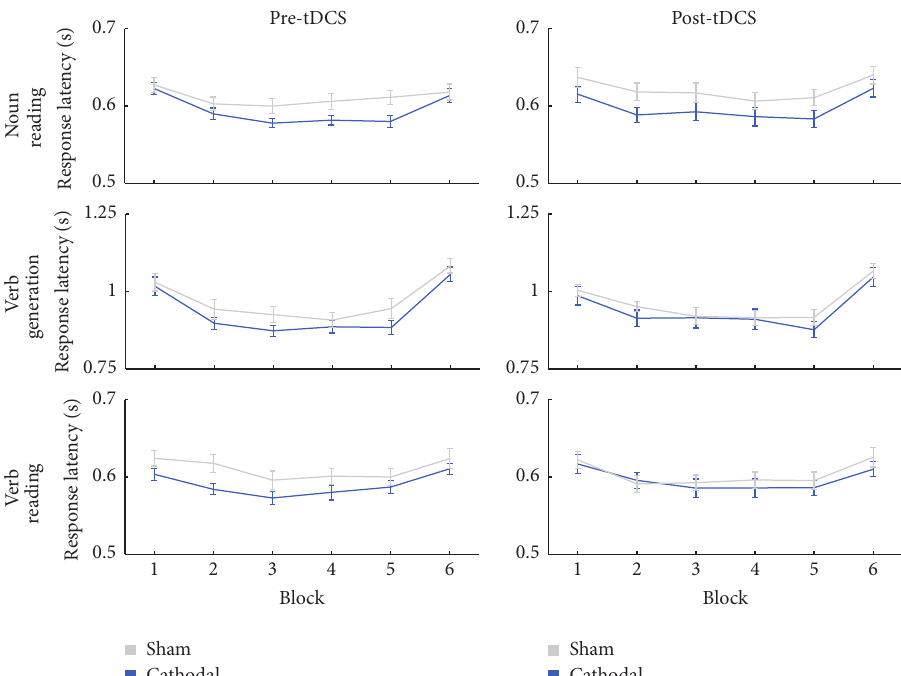
Figure 2: Results for the verbal response times (s), before and after tDCS, for each task and across the 6 blocks. Error bars represent the standard error of the mean (SEM).